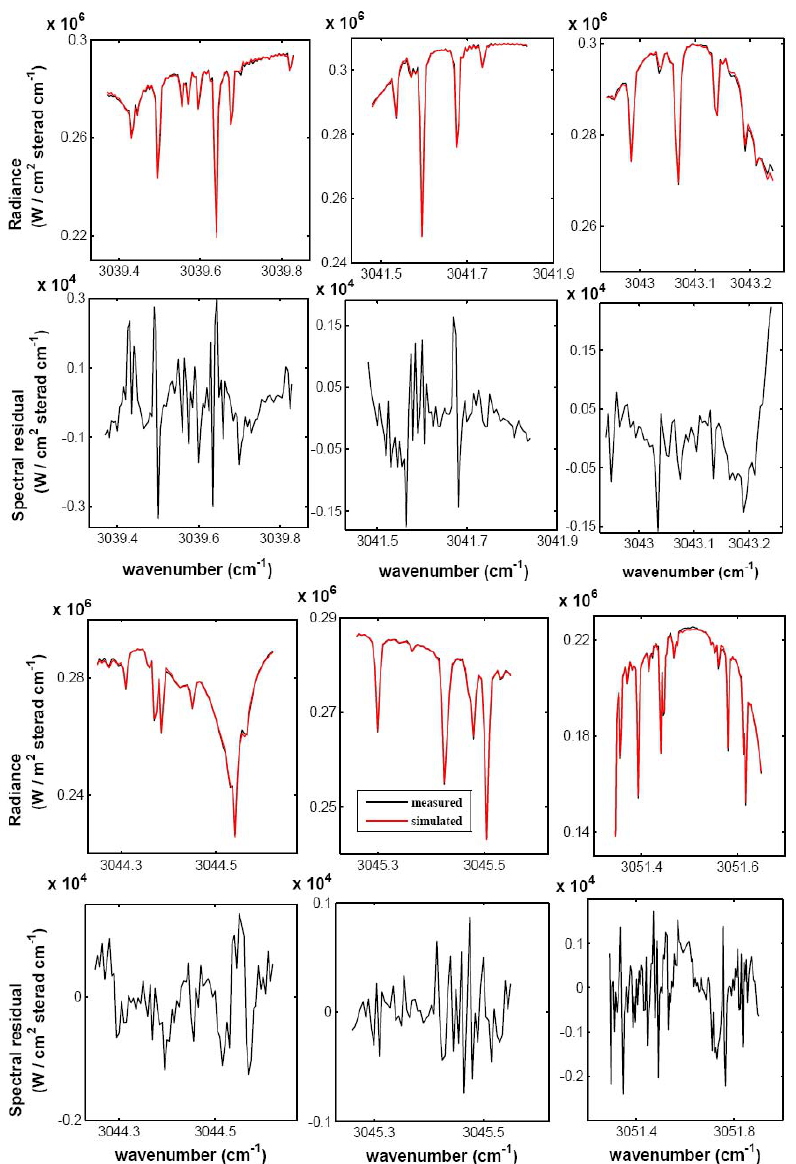
Fig. 2. O 3 – The top and the third panels show the measured spectrum (black line) and simulated spectrum (red line); and the second and the bottom panels show corresponding spectral residuals on 27 May 2010 for different spectral